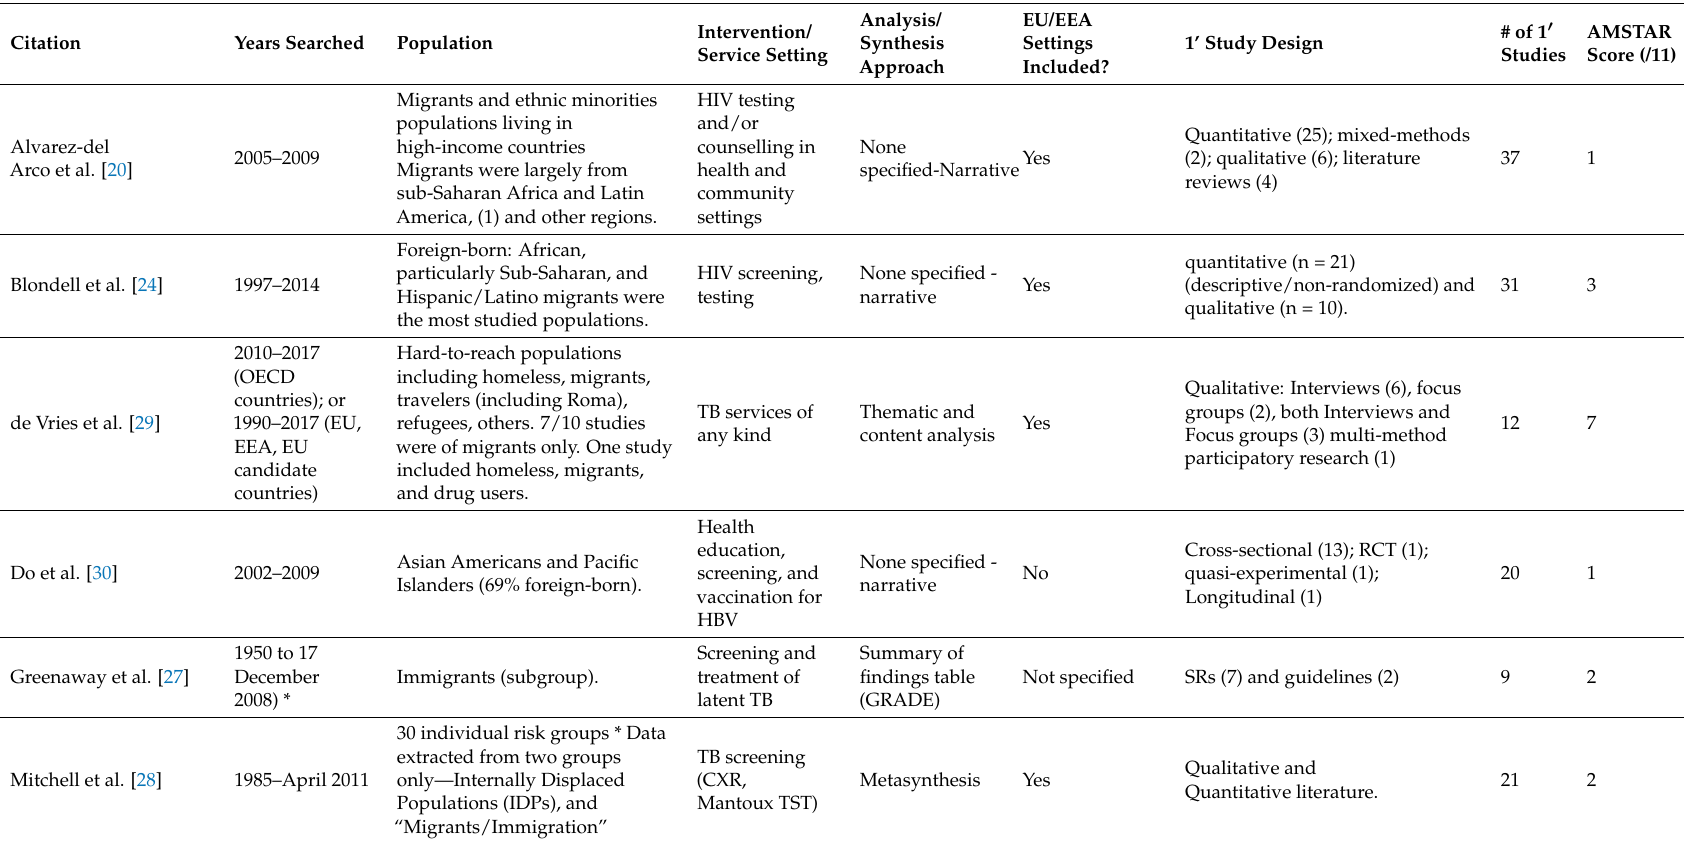
Table 1. Characteristics of Included